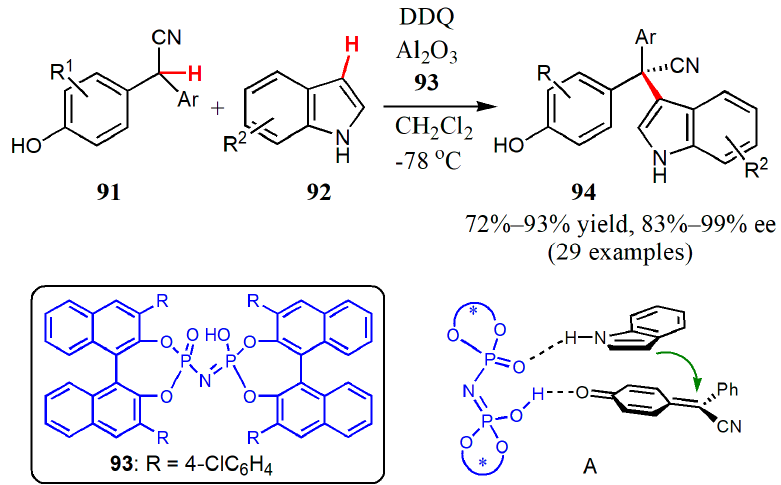
Figure 28. Synthesis of heteroarenes bearing triarylmethanes units with chiral all-carbon